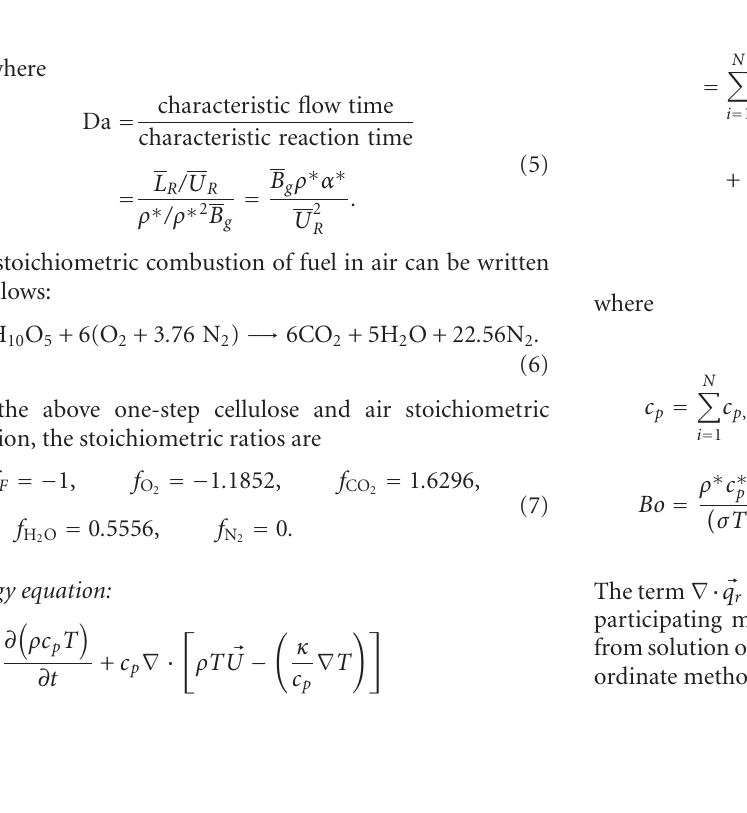
Figure 1: Schematic of a spreading flame over solid fuel and the computational